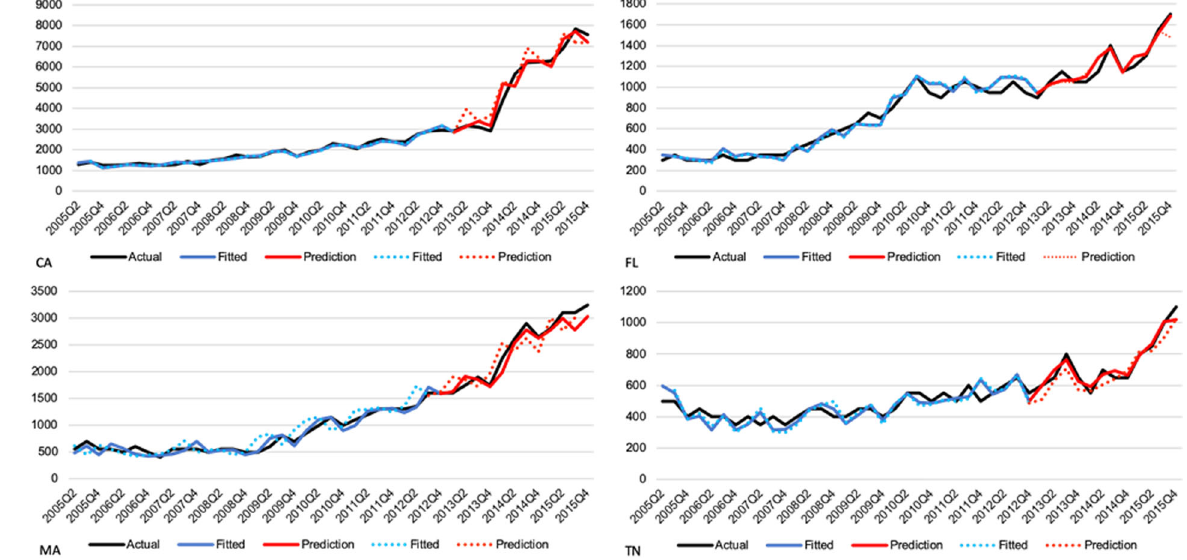
Fig. 1 Results. One-quarter-ahead (solid) and two-quarter-ahead (dashed) predictions of the ED visits for four typical states based on Google search and drug use data.